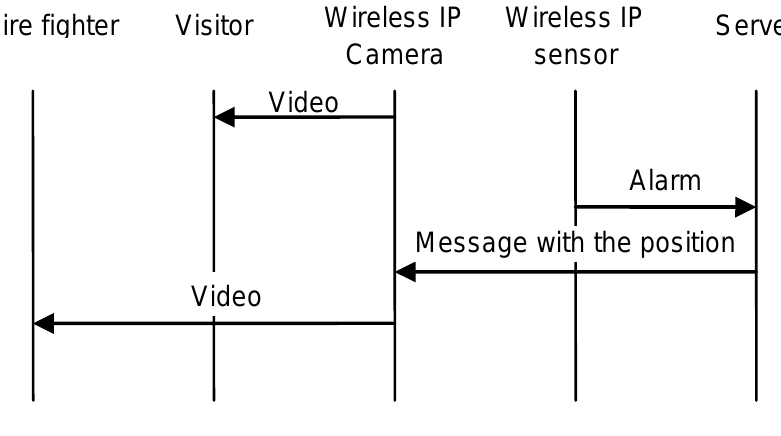
Figure 9. Messages when there is an